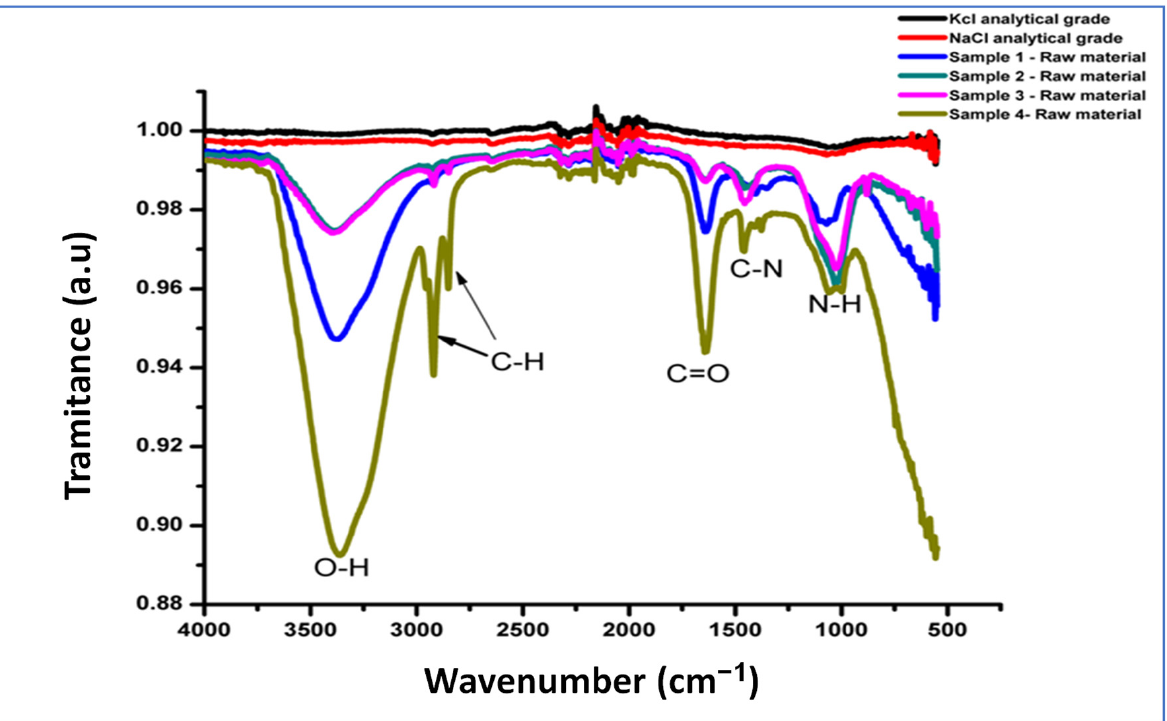
Figure 5. IR spectra of mineral samples without drying treatment. Sample 1: Blanco; Sample 2: BPC; Sample 3: Problema and Sample 4: Bueno.